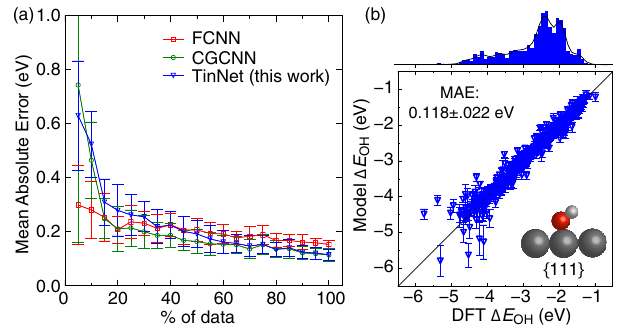
Fig. 2 Model development. a Learning curves of FCNN, CGCNN, and TinNet (this work) models of *OH adsorption energies on {111}-terminated intermetallics and near-surface alloys with respect to the number of available data samples. The error bar corresponds to the standard deviation of the error estimates from nested 10-fold cross-validation. b DFT- calculated vs. TinNet-predicted *OH adsorption energies for all 10-fold test sets, along with a histogram of data sampling. The error bar corresponds to the standard deviation of the error estimates from 10 fi nal models. Note: MAE represents mean absolute error, the color scheme of atoms includes light gray (H), red (O), and dark gray (metal).